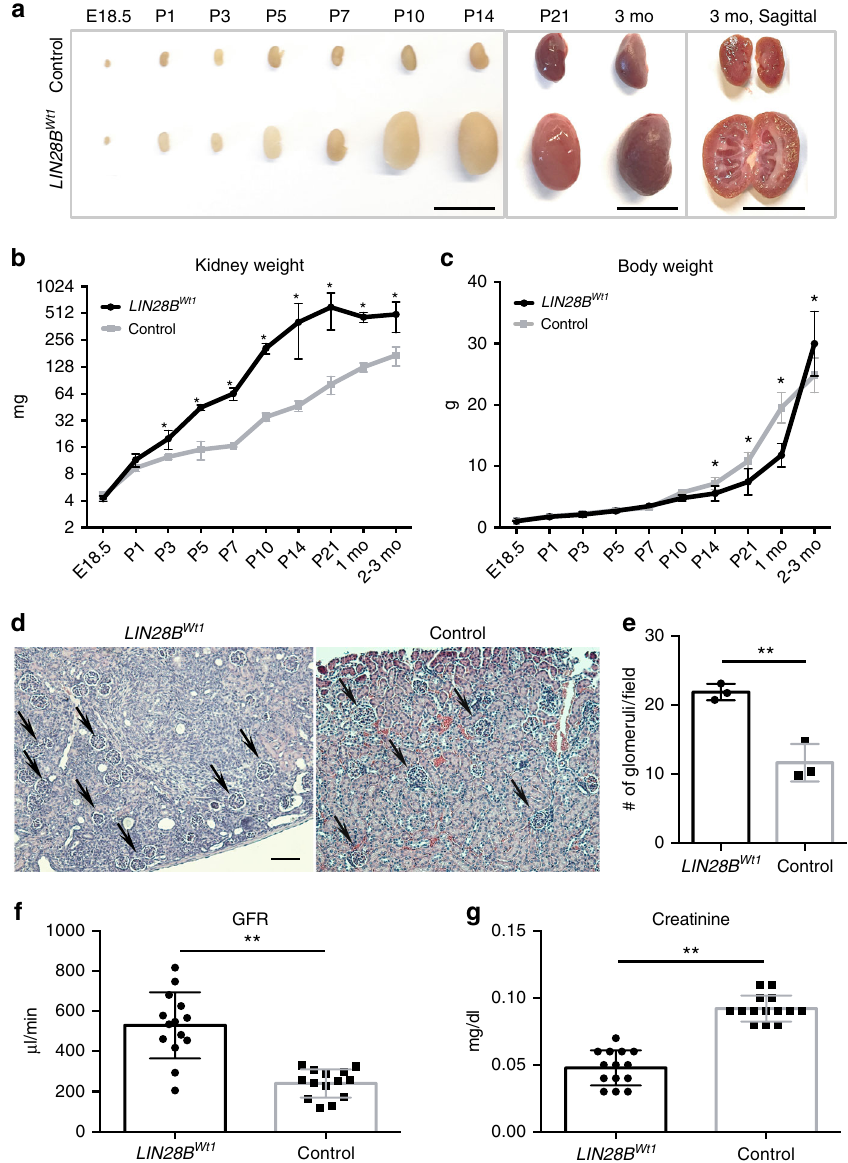
Fig. 3 Overexpression of LIN28B enhances renal function. a Representative images of LIN28B Wt1 and littermate control kidneys from E18.5 to 3 months old (m.o.) animals. Scale bar, 10 mm. b , c Kidney weight and body weight of LIN28B Wt1 and littermate control mice. n = 3 – 8 for each genotype. d Representative hematoxylin and eosin stain (H&E) image of 1m.o. LIN28B Wt1 and littermate control kidneys. Arrows point to glomerulus-like structures. Scale bar, 200 µ m. e Average number of glomeruli in 12 random fi elds from the kidney cortex under 10× magni fi cation. The slides were coded and counted blindly. n = 3 for each group. f , g Glomerular fi ltration rate (GFR) and creatinine levels of LIN28B Wt1 and littermate control animals (measured blindly). n = 14 for each genotype; each group contains mice from three different litters. Error bars represent mean ± SD. (*) = p < 0.05, (**) = p < 0.01, unpaired, two- tailed Student ’ s t